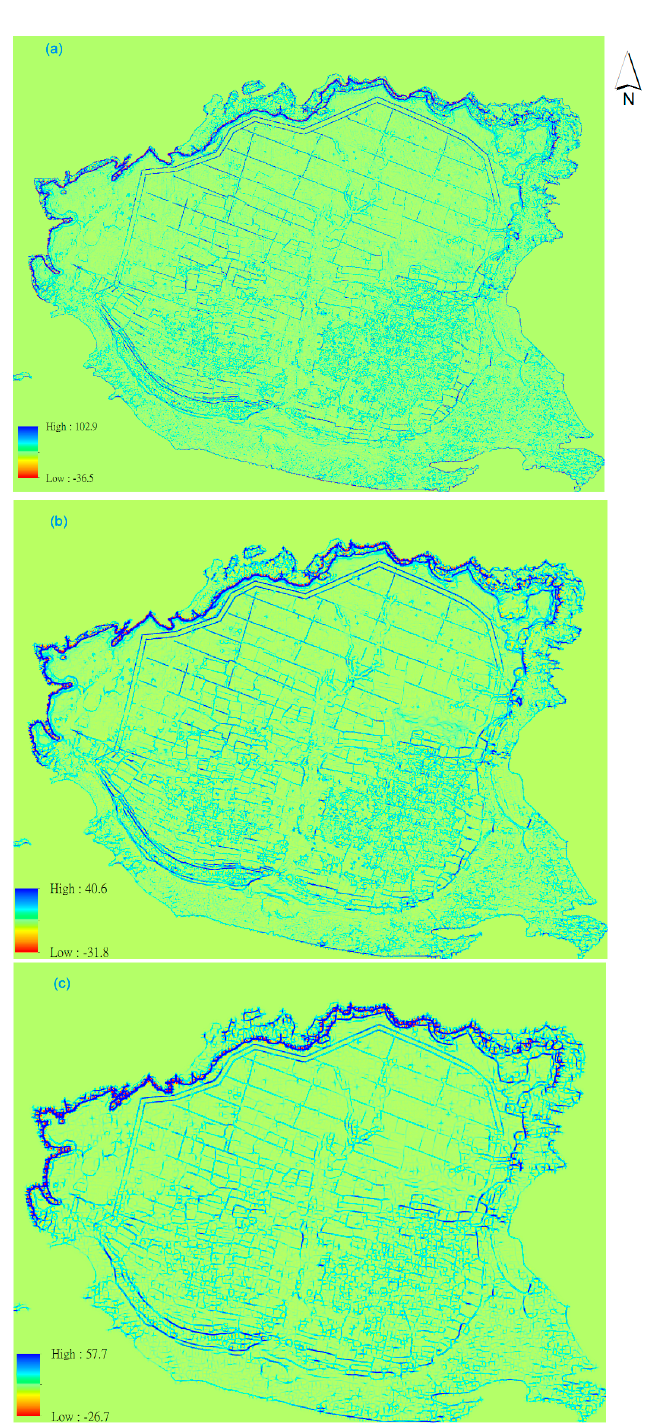
Figure 6. Maximum curvature maps with various scales in ( a ) 3 × 3, ( b ) 5 × 5, and ( c ) 7 × 7.